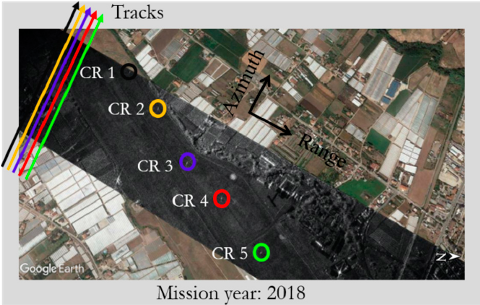
Figure 6. As Figure 2, but relevant to the Experiment 7. Number of exploited CRs (colored circles): 5. Number of exploited tracks (colored lines): 5. Mission year: 2018. Only one CR per track is used, according to the color correspondence adopted in the figure. The di ff erent flown tracks, which are almost overlapped, are depicted well separated just for graphical